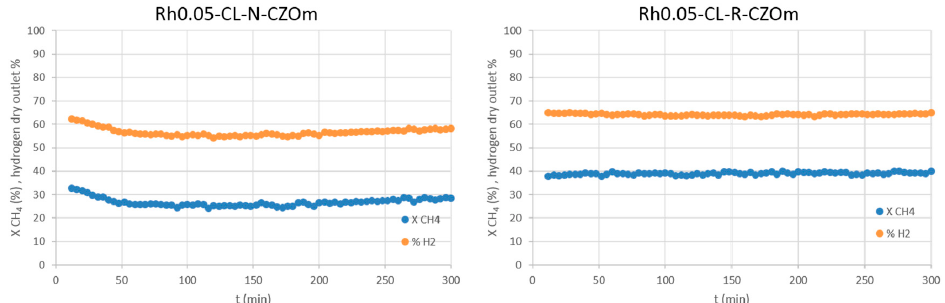
Figure 14. Methane conversion and hydrogen dry outlet percentage obtained on Rh0.05-CL-N-CZOm (left) and Rh0.05-CL-R-CZOm (right) tested at 750 °C, 30,000 h − 1 , 1 atm and S/C 1.5.